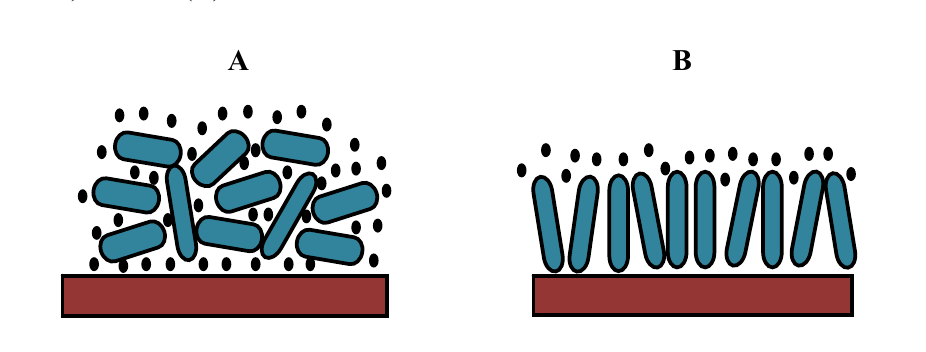
plasma-treated 4